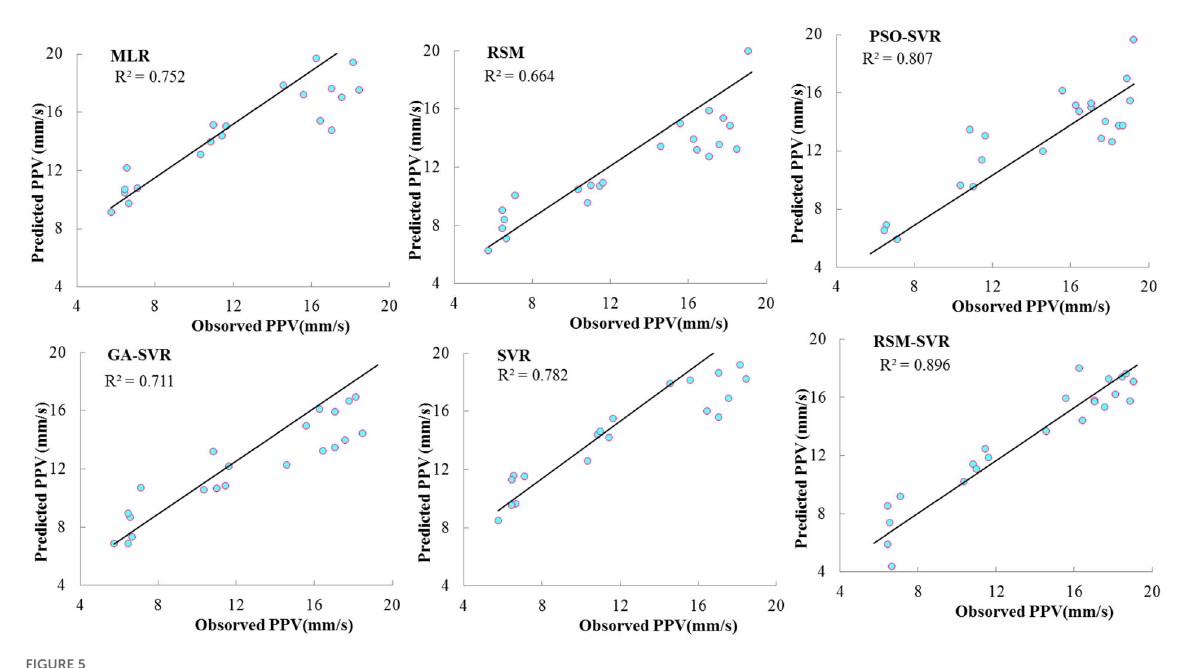
FIGURE5 Scatterplot of predicted and observed PPV for test data